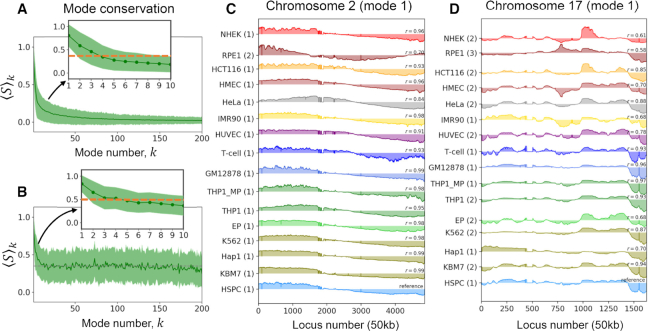
Conservation of the first global mode accessible to the chromatin. (A) Mode conservation profile as a function of mode number k reveals the high conservation of the global mode (\documentclass[12pt]{minimal}
\usepackage{amsmath}
\usepackage{wasysym}
\usepackage{amsfonts}
\usepackage{amssymb}
\usepackage{amsbsy}
\usepackage{upgreek}
\usepackage{mathrsfs}
\setlength{\oddsidemargin}{-69pt}
\begin{document}
}{}$k\ = \ 1$\end{document}). The profile displays the correlation cosines between individual mode shapes computed for each of the first 200 modes accessible to the entire chromatin averaged over all cell pairs (Equation 6). The solid green curve and the shade show the mean and standard deviation, respectively. (B) Same as panel A, after reorganizing the modes to select the equivalent modes that best match those of the reference cell, HSPC. Note the higher conservation of modes, but also the accompanying higher variance. See the counterparts of panels A and B for chromosomes 2, 8 and 17 in Figure 3 and Supplementary Figure S3. (C, D) Global mode shape for chromosomes 2 (C) and 17 (D), highly conserved across 16 cell lines. The curves represent the normalized spatial displacements of loci (abscissa) along the equivalent mode 1 axis. A central hinge region is observed in C at the crossover between positive and negative displacements near loci 2000–2500. The original mode numbers are shown in parentheses on the ordinate, and the correlation cosine with respect to the reference (HSPC) is indicated in each case.